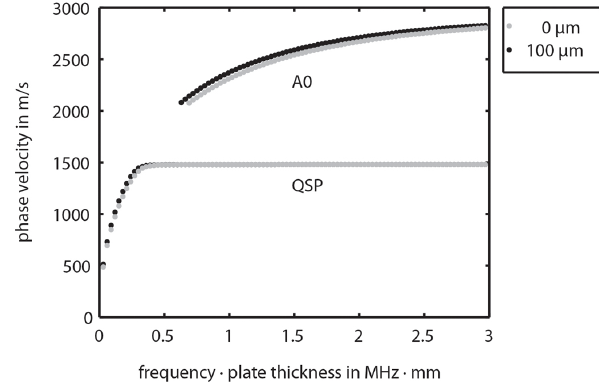
Figure 13. Dispersion diagram of a steel plate ( v l = 5707ms − 1 , v s = 3155ms − 1 , ρ = 7850kgm − 3 , d = 1mm) with and without a nickel coating ( v l = 5793ms − 1 , v s = 3202ms − 1 , ρ = 8000kgm − 3 ) of 100 µ m thickness in contact with a water half-space ( v l = 1480ms − 1 , ρ = 1000kgm − 3 ).